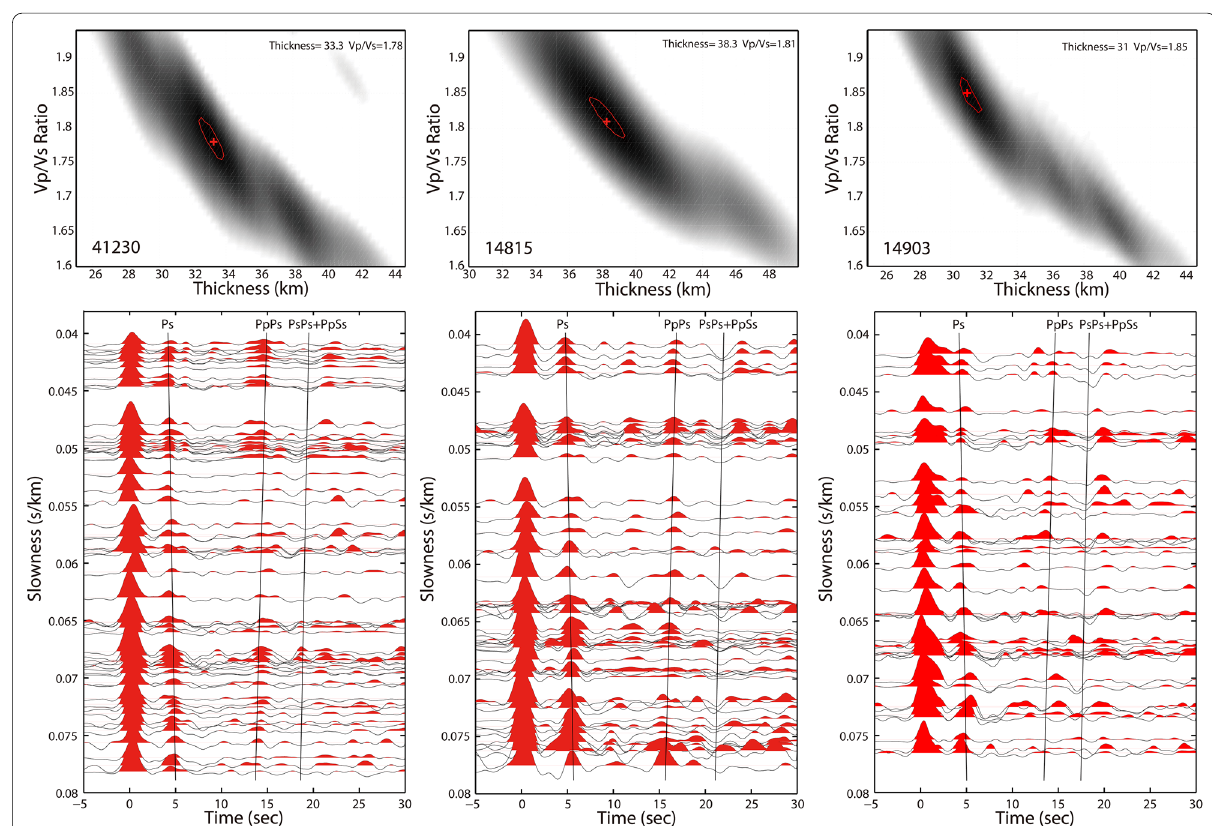
Fig. 5 H - κ Analysis of stations 41230, 14815 and 14903. The red crosses represent the best estimates of the crustal thickness and Vp/Vs ratio, and the red ellipses show the 97% confidence